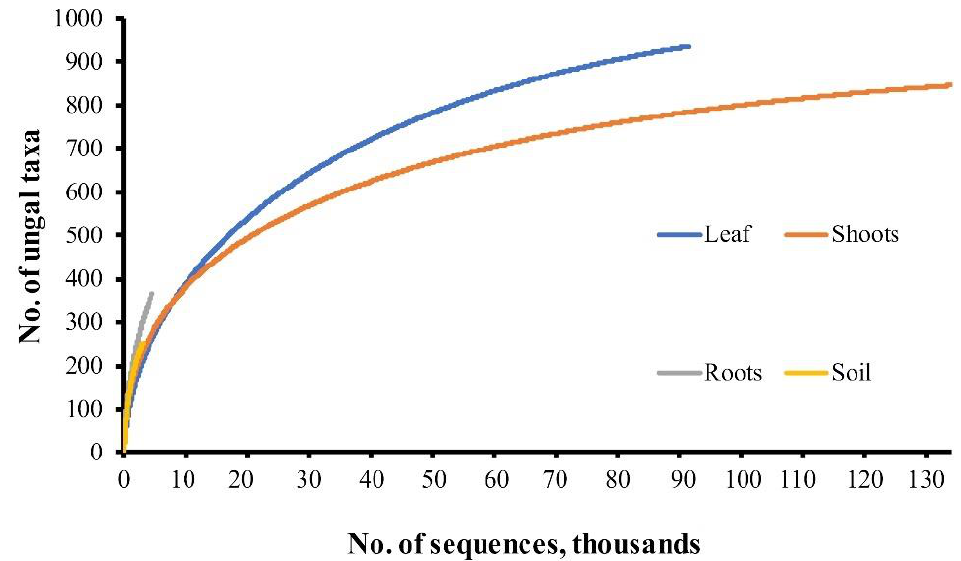
Figure 2. Rarefaction curves showing the relationship between the cumulative number of fungal taxa and the sequencing intensity.